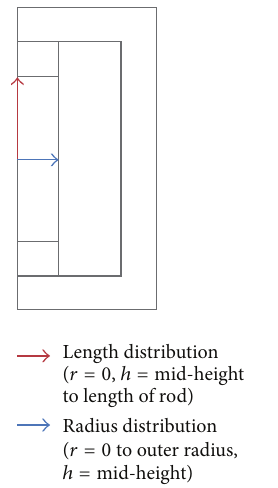
Figure 6: Axial field distribution described by multiloop model and FEM